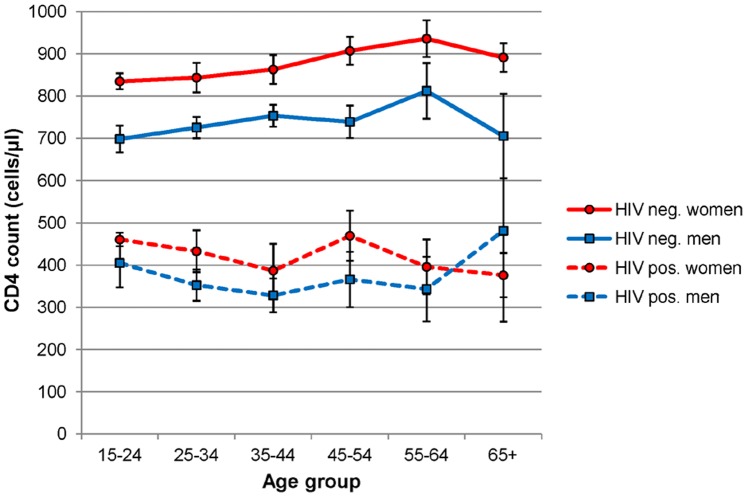
CD4 counts are higher in women than in men after stratifying by HIV status throughout all age groups except in older HIV-infected adults, where sample sizes are too small.Data points represent means and whiskers represent 95% confidence intervals of CD4 counts within HIV-status and age group strata.